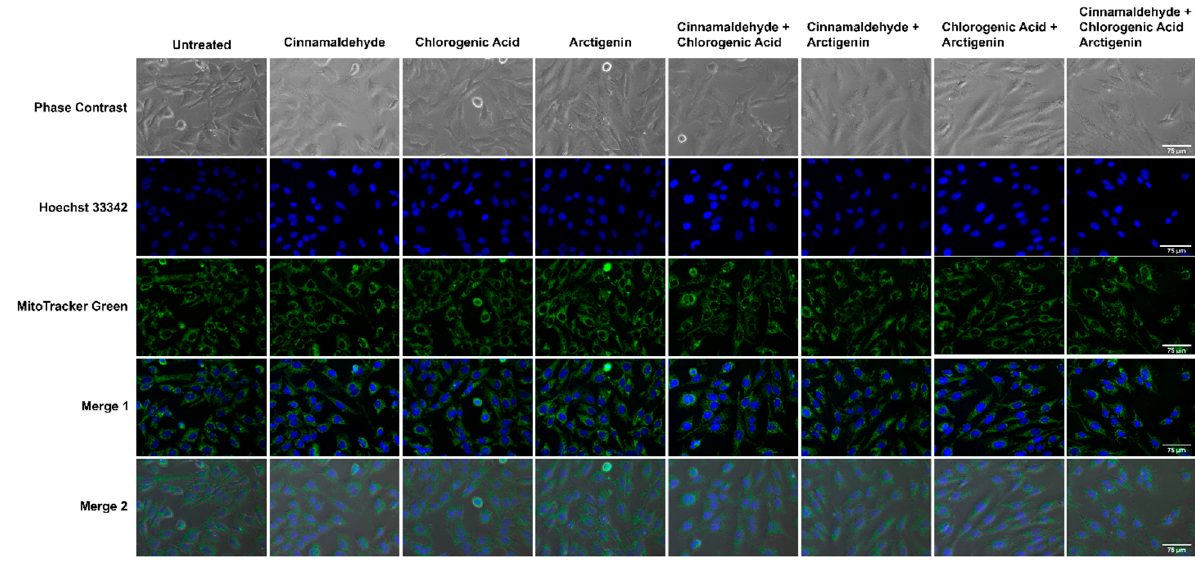
Figure 9. Representative fluorescence microscopy images of MCF-10A cells treated with 45 μ M CA, 250 μ g/mL CGA, and 100 μ M Arc, alone and in combination, for 24 h. After 24 h treatment, cells 250 µ g/mL CGA, and 100 µ M Arc, alone and in combination, for 24 h. After 24 h treatment, cells were stained with final concentrations of 150 μ M MitoTracker ® Green FM and 1 μ g/mL of Hoechst were stained with final concentrations of 150 µ M MitoTracker ® Green FM and 1 µ g/mL of Hoechst 33342 before visualization at 40× magnification (scale bar = 75 μ m). 33342 before visualization at 40 × magnification (scale bar = 75 µ